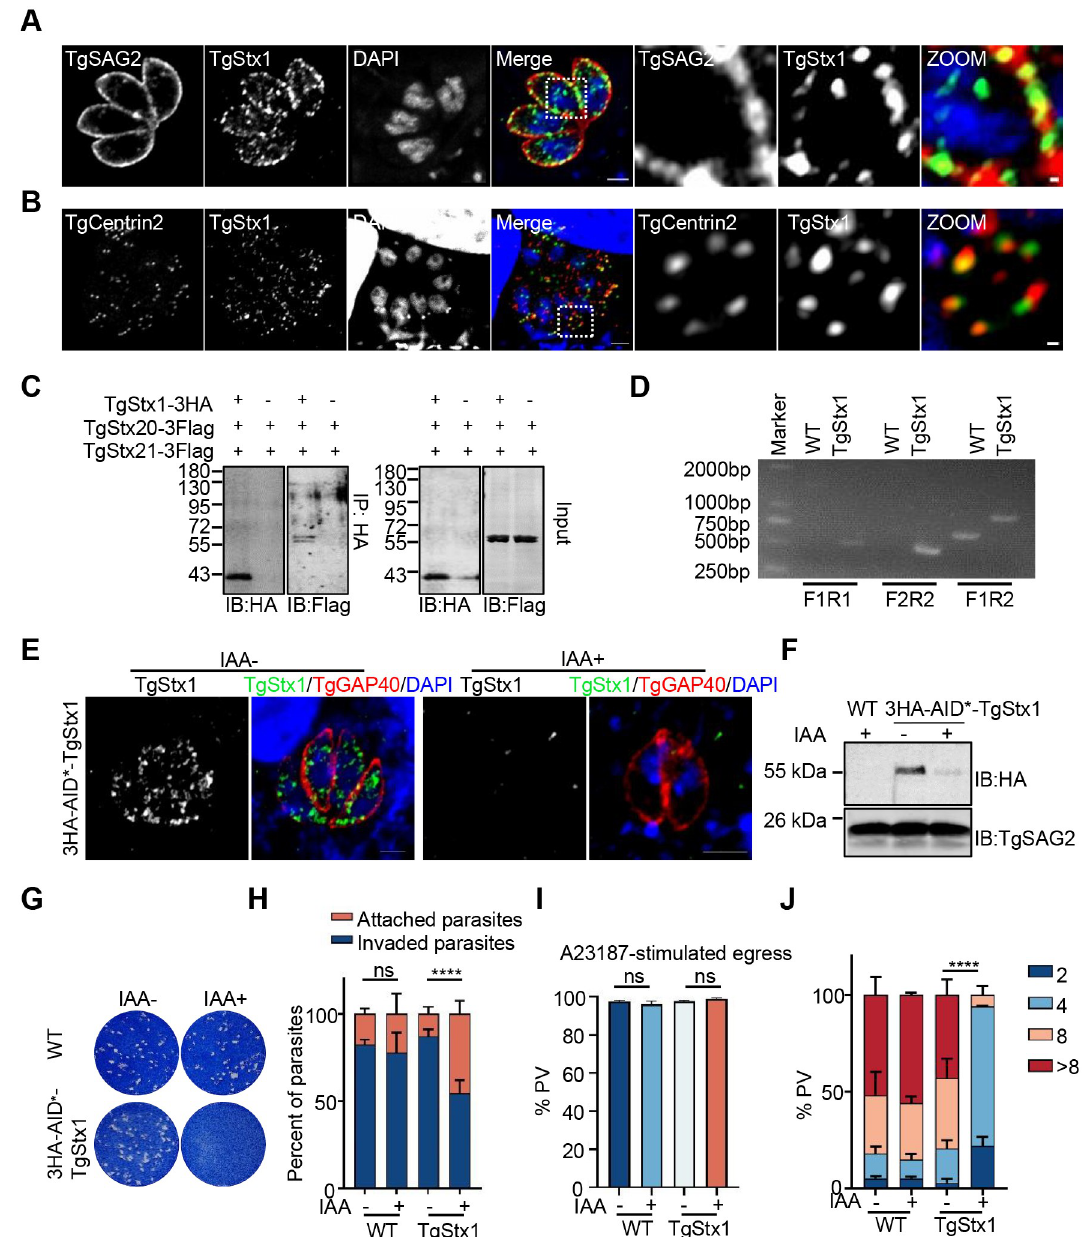
Fig 5. TgStx1 is essential for the lytic cycle of T . gondii . (A) IFA showing that TgStx1 (green) partially colocalized with the plasma membrane protein TgSAG2 (red). Scale bars: 2 μ m (left panels) and 0.2 μ m (zoomed panels). (B) IFA showing that 3HA-AID * -TgStx1 (red) partially colocalized with Tgcentrin2 (green). 3HA-AID * -TgStx1 parasites were transiently transfected with a plasmid expressing TgCentrin2 fused with EGFP and subjected to an IFA. Scale bars: 2 μ m (left panels) and 0.2 μ m (zoomed panels). ( C ) Co- immunoprecipitation of 3HA-tagged TgStx1 and 3Flag-tagged TgStx20 and TgStx21. HEK293T cells transiently expressing 3HA-TgStx1, 3Flag-TgStx20, and 3Flag-TgStx21 were subjected to immunoprecipitation. IP, immunoprecipitation; IB, immunoblot. ( D ) Genomic PCR analysis confirming homologous recombination of the genomic 3HA-AID * -TgStx1 locus using the indicated primers. ( E ) 3HA-AID * -TgStx1 parasites were transiently transfected with a plasmid expressing TgGAP40-YFP, cultured with or without IAA for 24 h, and stained with an antibody against HA (green). Scale bars: 2 μ m. ( F ) The parasites were cultured in the presence or absence of IAA for 12 h in vivo and lysed. The expression of AID * -tagged TgStx1 was evaluated by WB analysis. ( G ) Plaque assays were performed by infecting BJ-5ta cells with 3HA-AID * -TgStx1 parasites for 6 d in the presence or absence of IAA. ( H ) Invasion assay examining the ability of 3HA-AID * -TgStx1 parasites to attach to and invade host cells in the presence or absence of IAA. Parasites were grown for 6 h in the presence or absence of IAA before the invasion. The data were analyzed for statistical significance by the unpaired t-test; **** P < 0.0001. ( I ) Egress of 3HA-AID * -TgStx1 parasites from host cells was determined by an IFA.